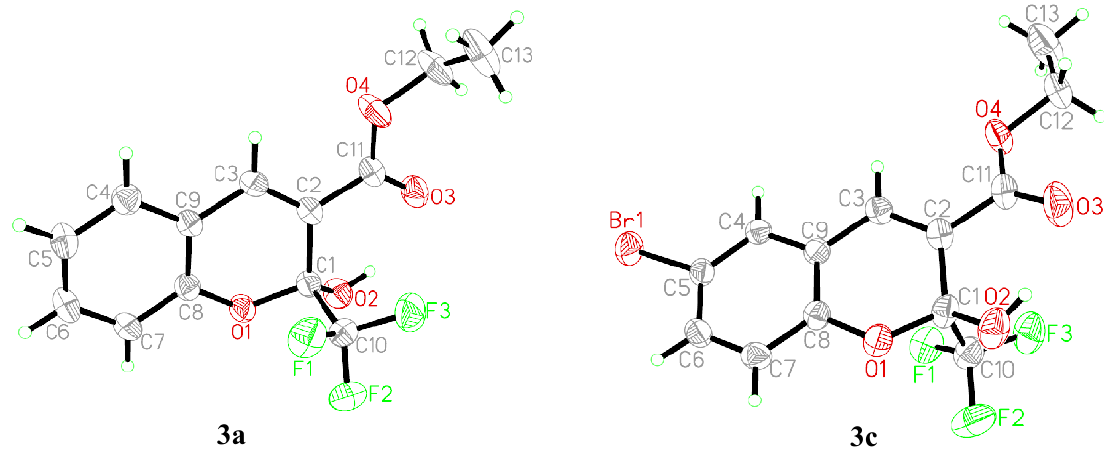
Figure 1. The molecular structures of 3a and 3c , showing the atomic numbering scheme and displacement ellipsoids draw at the 30% probability level.